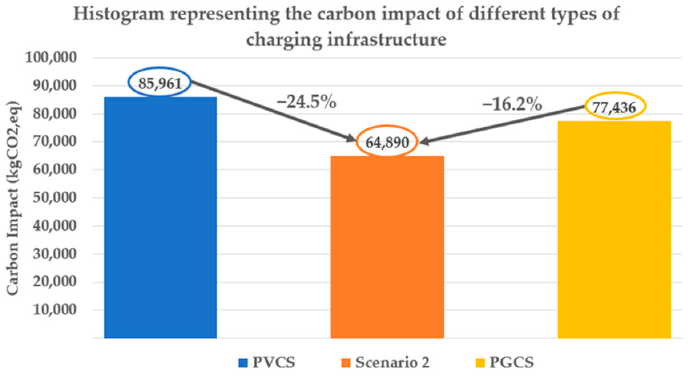
Figure 9. Result of scenario 2.